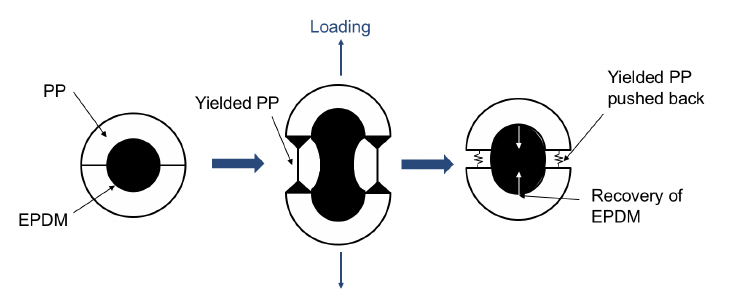
Figure 9. Deformation mechanisms of TPV